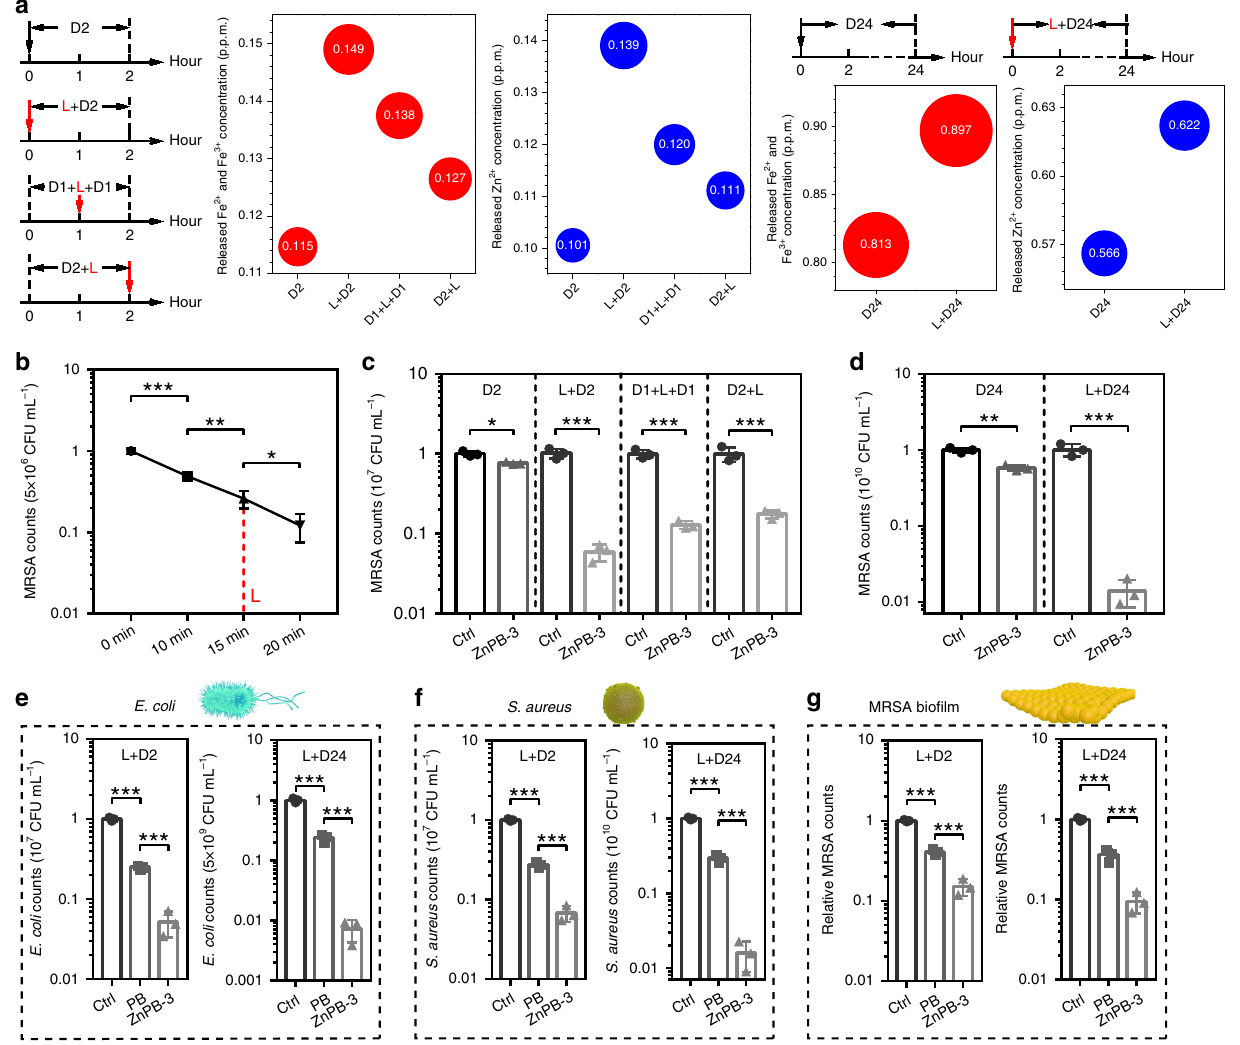
Fig. 5 Antibacterial activity in vitro. a Schema of giving 808 nm NIR light irradiation at different time point (0, 1 and 2 h) and corresponding amounts of Fe 2 + , Fe 3 + and Zn 2 + release after different treatment, including D2, L + D2, D1 + L + D1, D2 + L, D24 and L + D24 (L: light; D: dDark). b Kinetics of viability of MRSA treated with ZnPB-3 (200 p.p.m.) by 808 nm NIR light irradiation in 20 min (L: 15 min). c , d Viability of MRSA treated with ZnPB-3 (200 p.p.m.) through different treatment, including c D2, L + D2, D1 + L + D1 and D2 + L, d D24 and L + D24 (Ctrl: control). e – g Viability of MRSA treated with ZnPB-3 (200 p.p.m.) for e E. coli , f S. aureus and g MRSA bio fi lm through different treatment (L + D2 and L + D24). Error bars indicate means ± standard deviations ( n = 3 biologically independent samples): * P < 0.05, ** P < 0.01 and *** P < 0.001 ( t test). Source data are provided as a Source Data fi treated bacteria and ZnPB-3 is centrifuged and separated with than that of PB (69.46 ± 2.69%, P < 0.001), ZnPB-1 (81.18 ± 3.27%, P < 0.01) and ZnPB-2 (89.66 ± 2.36%, P < 0.05) against Fig. 11, for separate incubations for 2 h (72.16 ± 2.67%, P < 0.001) MRSA in the L + D24 treatment, demonstrating that ZnPB-3 has and 24 h (69.41 ± 1.72%, P < 0.001) in the dark without the effect the highest antibacterial rate. of ion release after L treatment, a lower bacterial killing ef fi ciency The antibacterial activity of ZnPB-3 (200 p.p.m.) is assessed against MRSA is displayed than that for the L + D2 group and L against Escherichia coli , S. aureus , and MRSA bio fi lm through + D24 group, further demonstrating the synergistic antimicrobial different treatments (L + D2 and L + D24). For E. coli (Fig. 5d), ef fi ciency of heat and ion release of ZnPB-3. This enhanced ZnPB-3 (94.83 ± 1.85% in the L + D2 group and 99.27 ± 0.29% in inactivation ef fi ciency by different treatments can be attributed to the L + D24 group) displays dramatically greater bacterial killing the fact that the local heat triggered by a photothermal effect not ef fi ciency ( P < 0.001) than that of PB (74.94 ± 1.24% in the L + only accelerates the release of ions but also damages the bacterial D2 group and 76.02 ± 3.25% in the L + D24 group). For S. aureus membrane. That is, the photothermal effect of ZnPB-3 will (Fig. 5e), the disinfection rates of ZnPB-3 (93.26 ± 1.53% in the L + D2 group and 98.42 ± 0.69% in the L + D24 group) are permeability, leading to further permeation of released ions and signi fi cantly greater ( P < 0.001) than that of PB (72.55 ± 2.04% in the L + D2 group and 70.45 ± 3.07% in the L + D24 group). bacteria. The related mechanism will be discussed later. Particularly for the MRSA bio fi lm, the bacteria are encapsulated in self-produced extracellular polymeric substances, which serve group (98.59 ± 0.56%, P < 0.05) has a higher antibacterial rate as a protective barrier. Therefore, the bactericidal ef fi ciency for